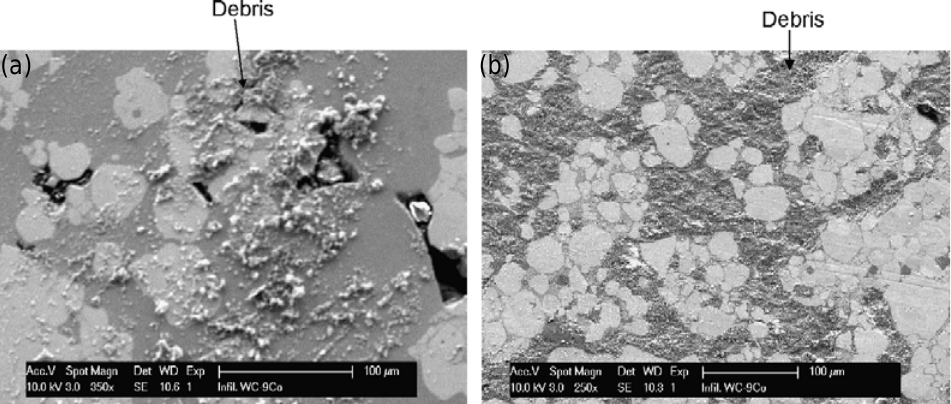
Figure 19. Micrographs of infiltrated WC 9Co samples after fretting tests ( a ) load 2N, ( b ) load 4N. Reproduced from [67], with permission from Elsevier, 2009.